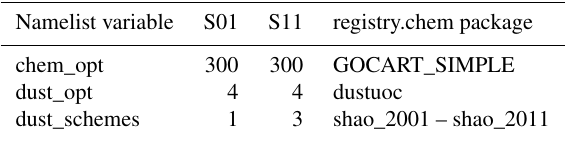
Table 2. Namelist settings of the chemical and dust emission pa- rameterization used in the WRF-Chem